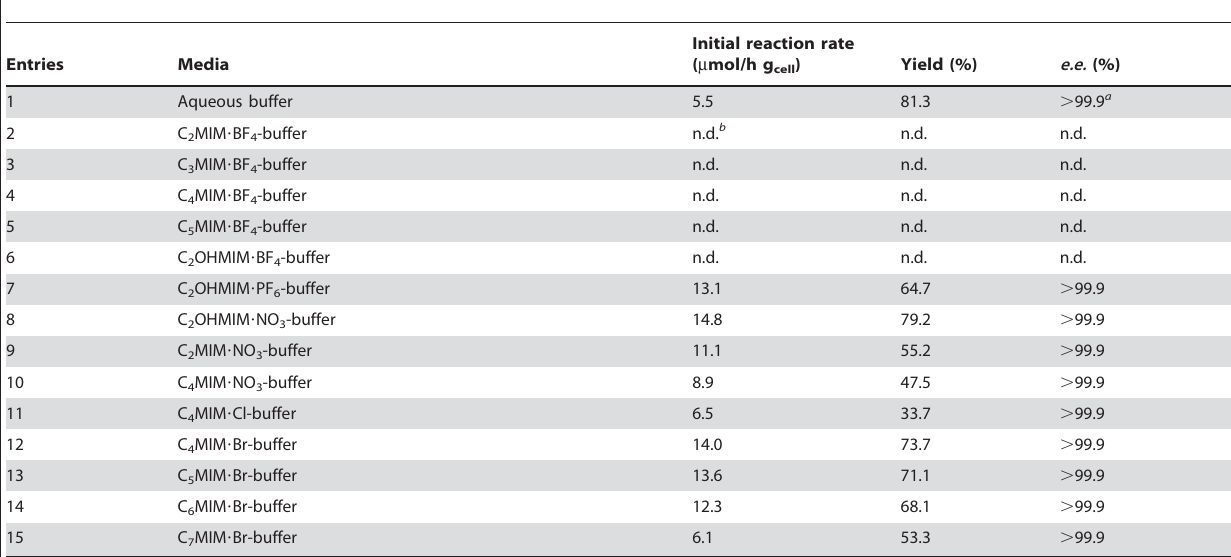
Table 1. Effect of various hydrophilic ILs on the bioreduction of TMSB with immobilized Candida parapsilosis cells.